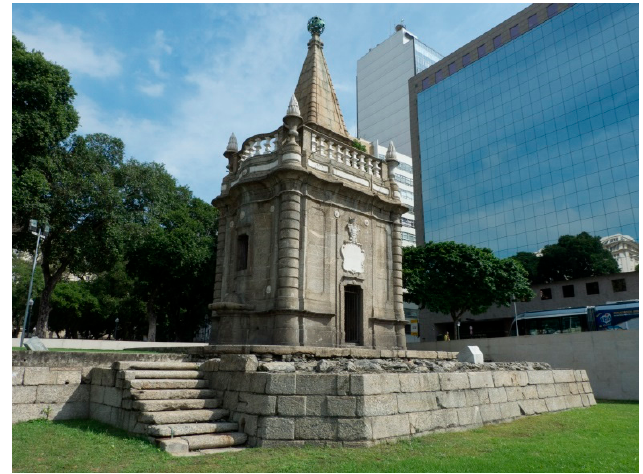
Figure 1. Master Valentim’s fountain, located in Rio de Janeiro, Brazil.